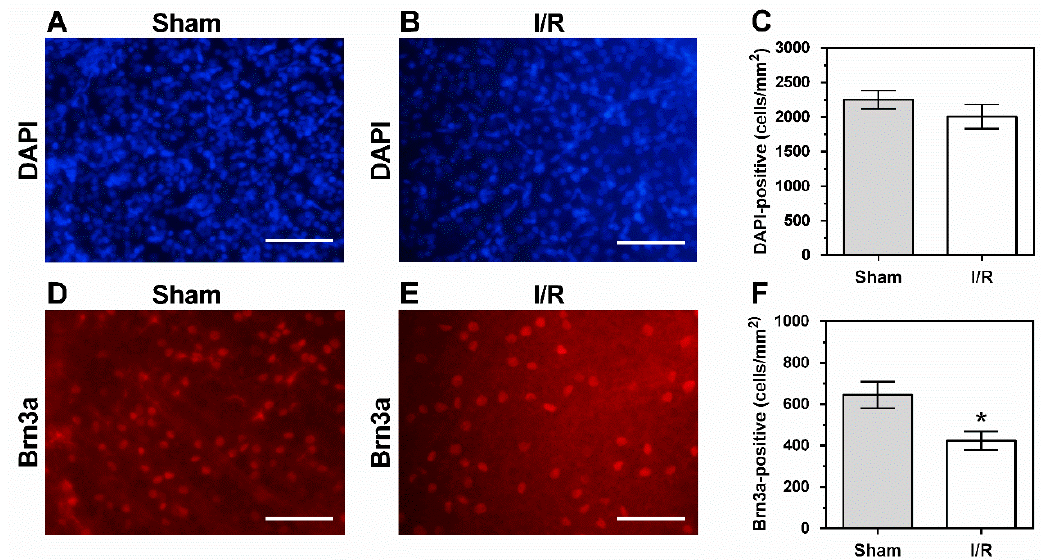
Figure 7. Representative pictures of DAPI-positive cells in sham-treated ( A ) and in I / R-treated pig retinas ( B ). No differences in density of DAPI-positive cells were detected between both groups ( C ). Pictures of Brn3a-stained cells in sham-treated ( D ) and in I / R-treated pigs ( E ). Of note, density of Brn3a-stained cells was markedly reduced in the I / R group ( F ). Data are presented as mean ± SE ( n = 6 per group; * p < 0.05). Scale bar = 100 μ m.